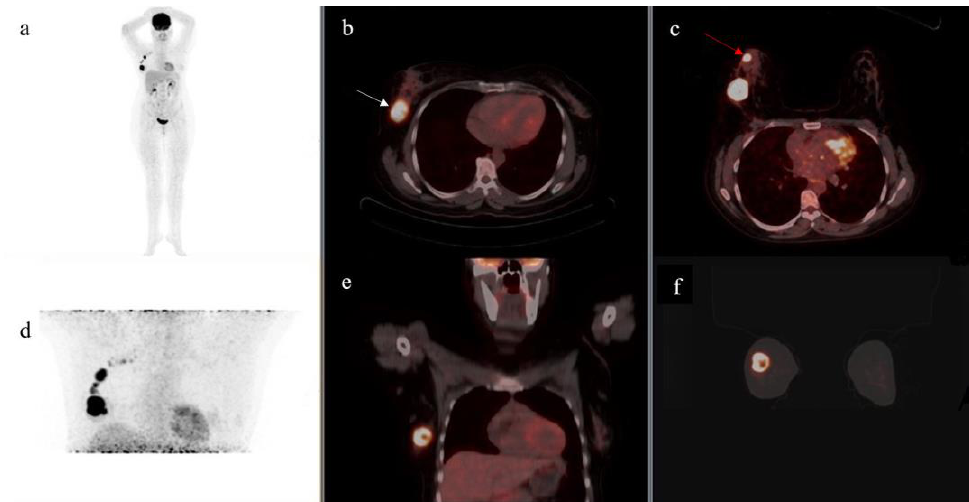
Figure 2. Axial PET and fused PET/CT images of the breast. Two small lesions (yellow arrows) are visualized within the left breast in prone acquisition ( b , d ), corresponding to multi-focal disease. Supine acquisition ( a , c ) showing single focal uptake in the left breast .